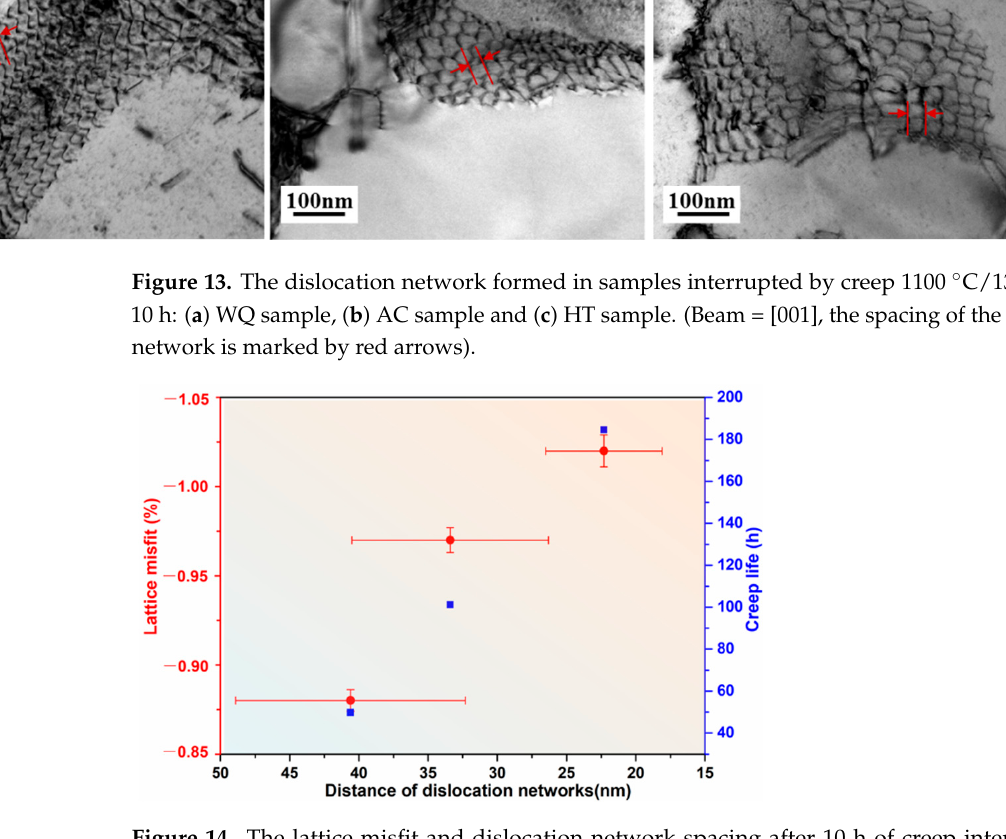
Figure 13. The dislocation network formed in samples interrupted by creep 1100 °C/137 MPa for 10 h: ( a ) WQ sample, ( b ) AC sample and ( c ) HT sample. (Beam = [001], the spacing of the dislocation network is marked by red arrows). Table 6. γ - and γ′ phase compositions after interruption of crept 10 h (at.%).